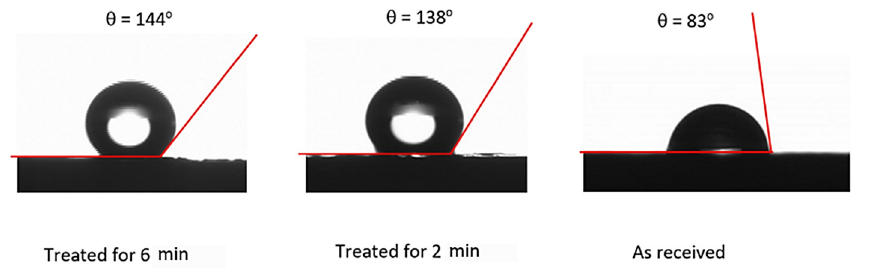
Figure 4. Optical image of droplet on 6 and 2 min treated surfaces, and as received surface. Images are obtained from Goniometer.